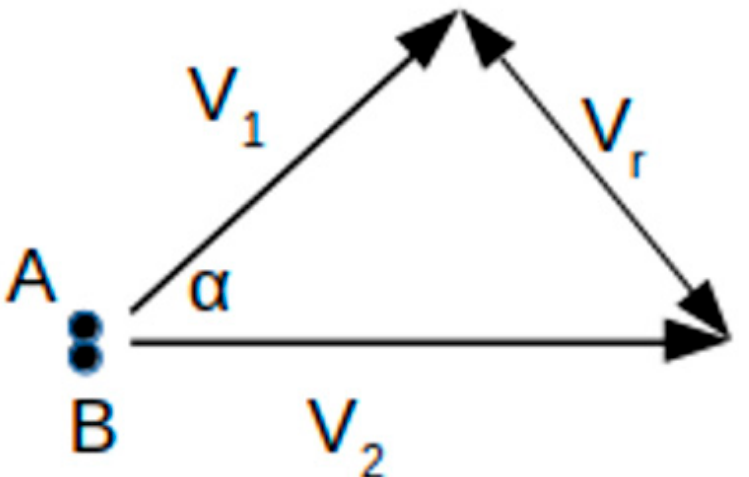
Figure 2. Relative velocity for which nodes A and B diverge.